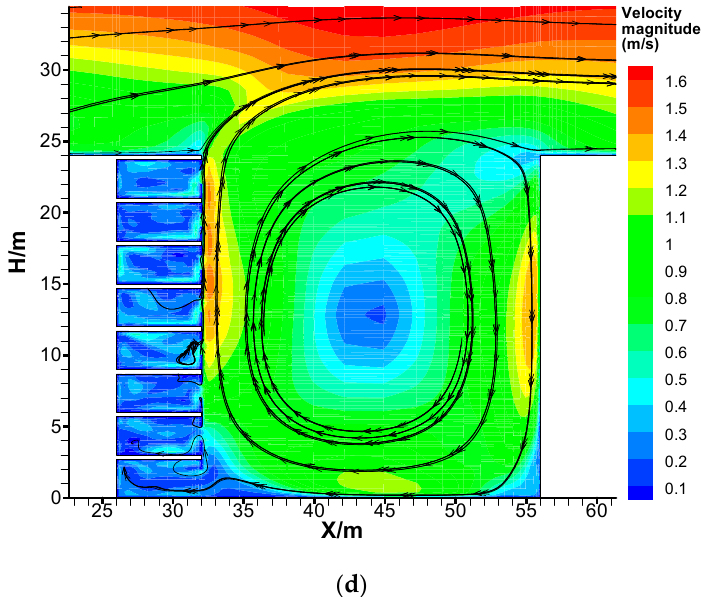
Figure 3. Streamline and velocity in street canyons with single-side ventilation mode under isothermal condition in the target canyon ( a ); with an indoor wall-heating condition in ( b ) the target canyon, ( c ) canyon 2 and ( d ) canyon 4.